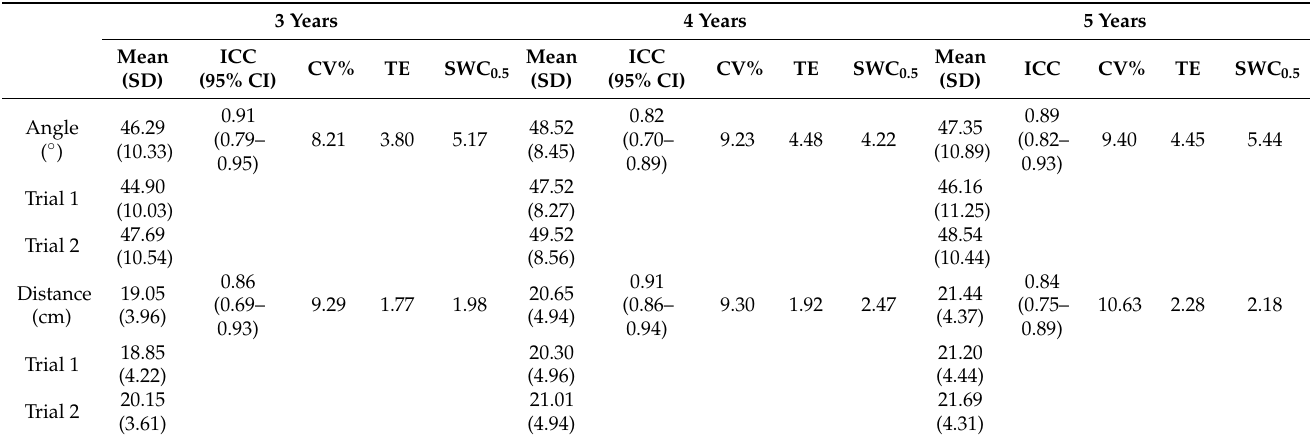
Table 2. Descriptive and reliability parameters for MSR angle and MSR distance scores in three age groups.